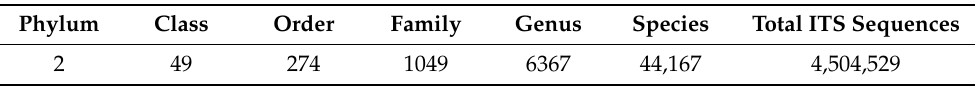
Table 1. Taxonomic level-wise distribution of ITS sequences in the dataset after filtering for duplicates and ambiguous